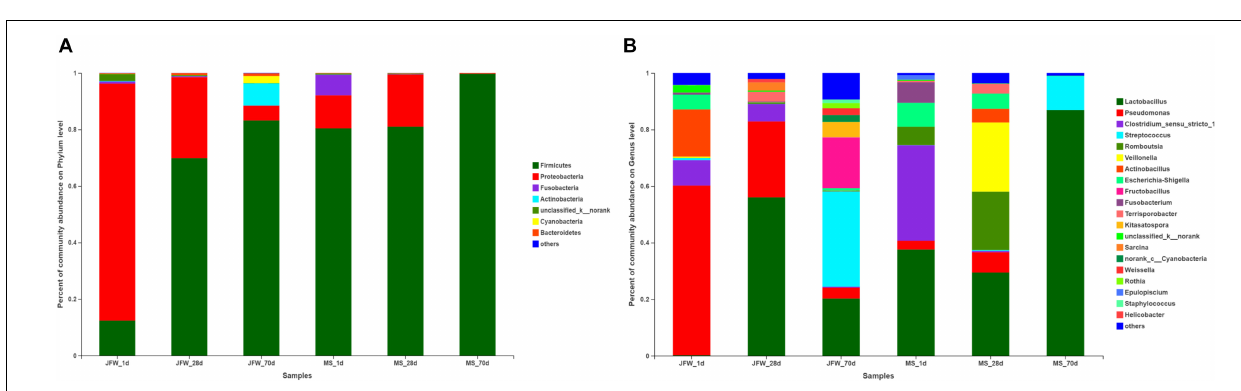
FIGURE 4 | Principal coordinates analysis (PCoA) of the samples based on the OTU profiling.